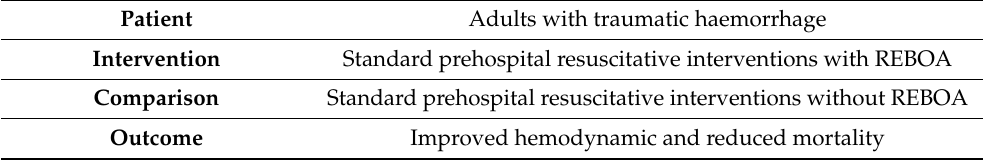
Table 1. PICO of the